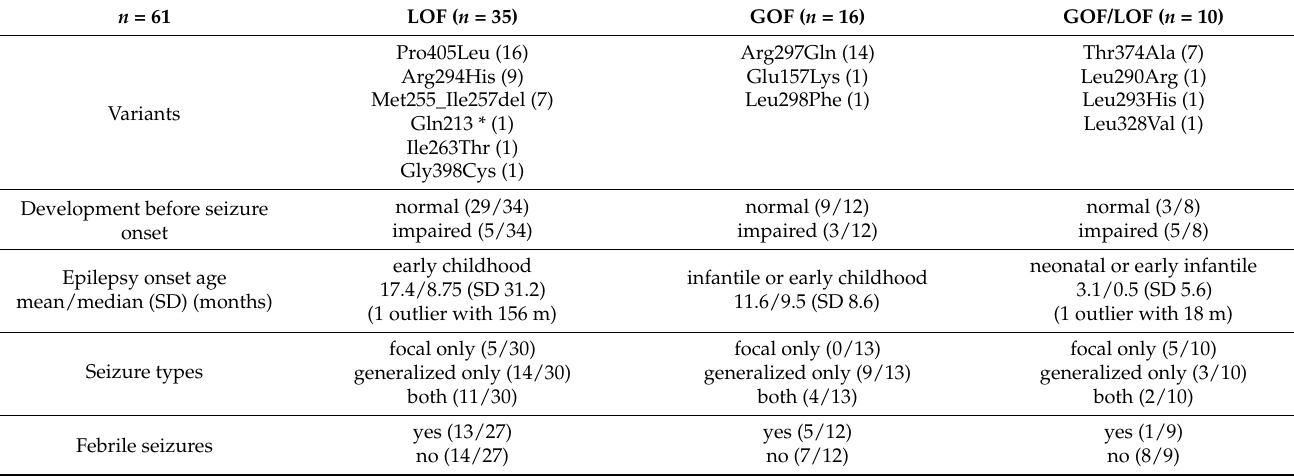
Table 4. Phenotypic features of reported and novel patients, grouped according to known functional consequences on K v